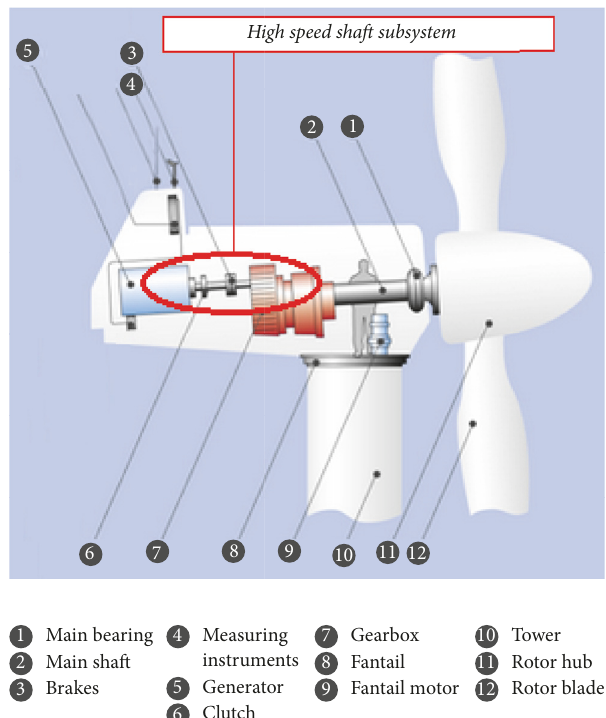
Figure 1: Overview of a high speed shaft subsystem as part of wind turbine drive train [52].